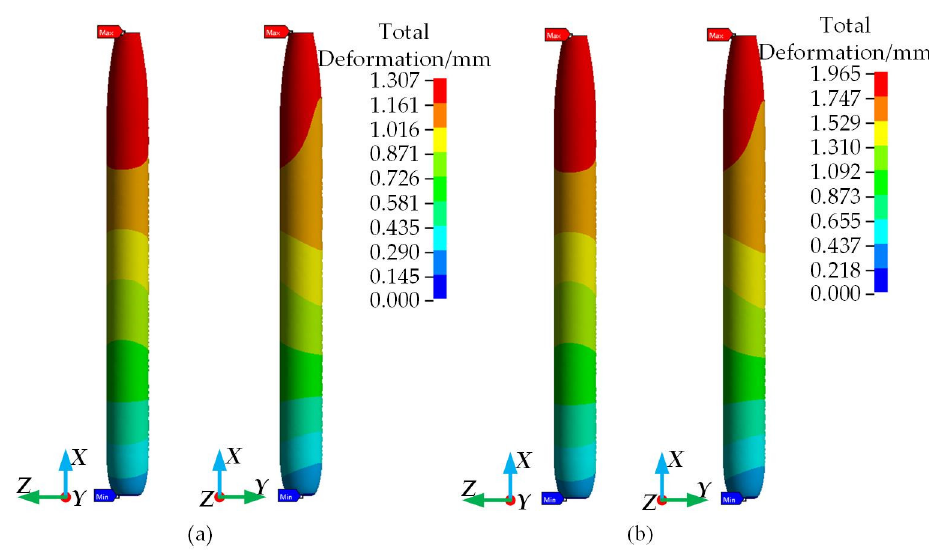
Figure 25. Structural response of the vehicle entering water vertically at speed of 100 m/s, ( a ) with buffer, ( b ) without buffer.